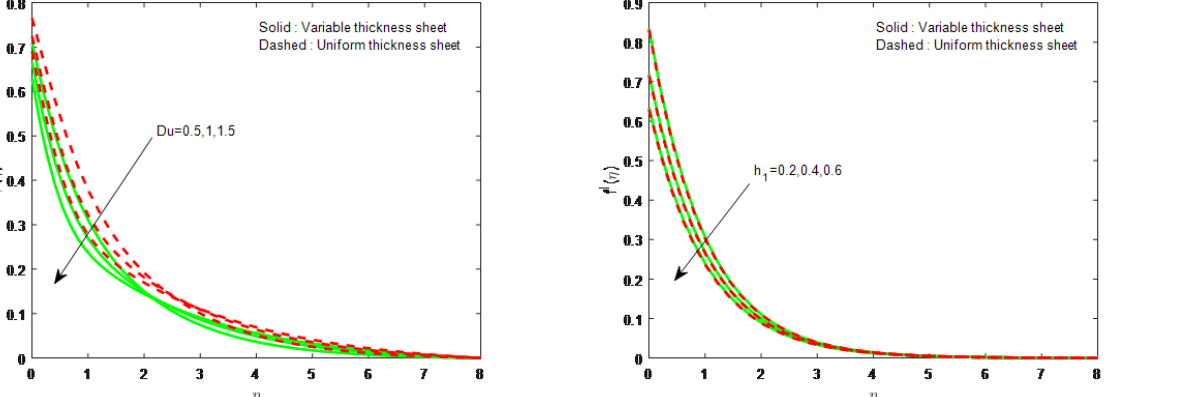
Fig. 11: Influence of Du on concentration field